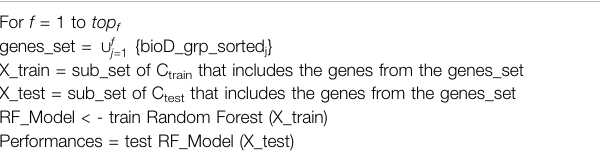
TABLE 3 | Pseudocode of component M, which calculates the